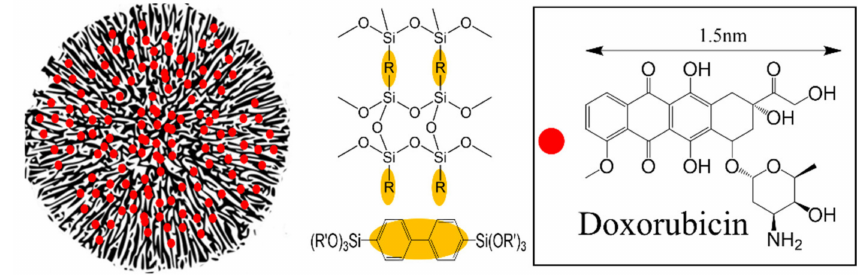
Figure 1. Biphenyl bridged wrinkled silica loaded with